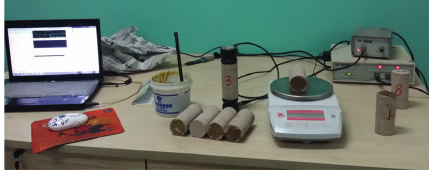
Figure 2: Weighing and acoustic testing of rock